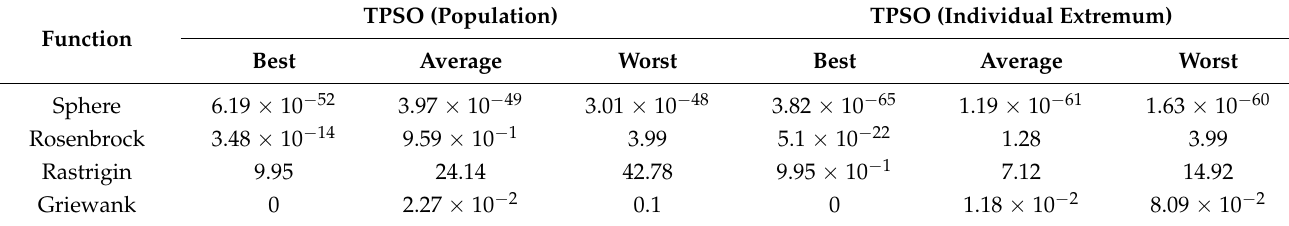
Table 3. Convergence accuracy.